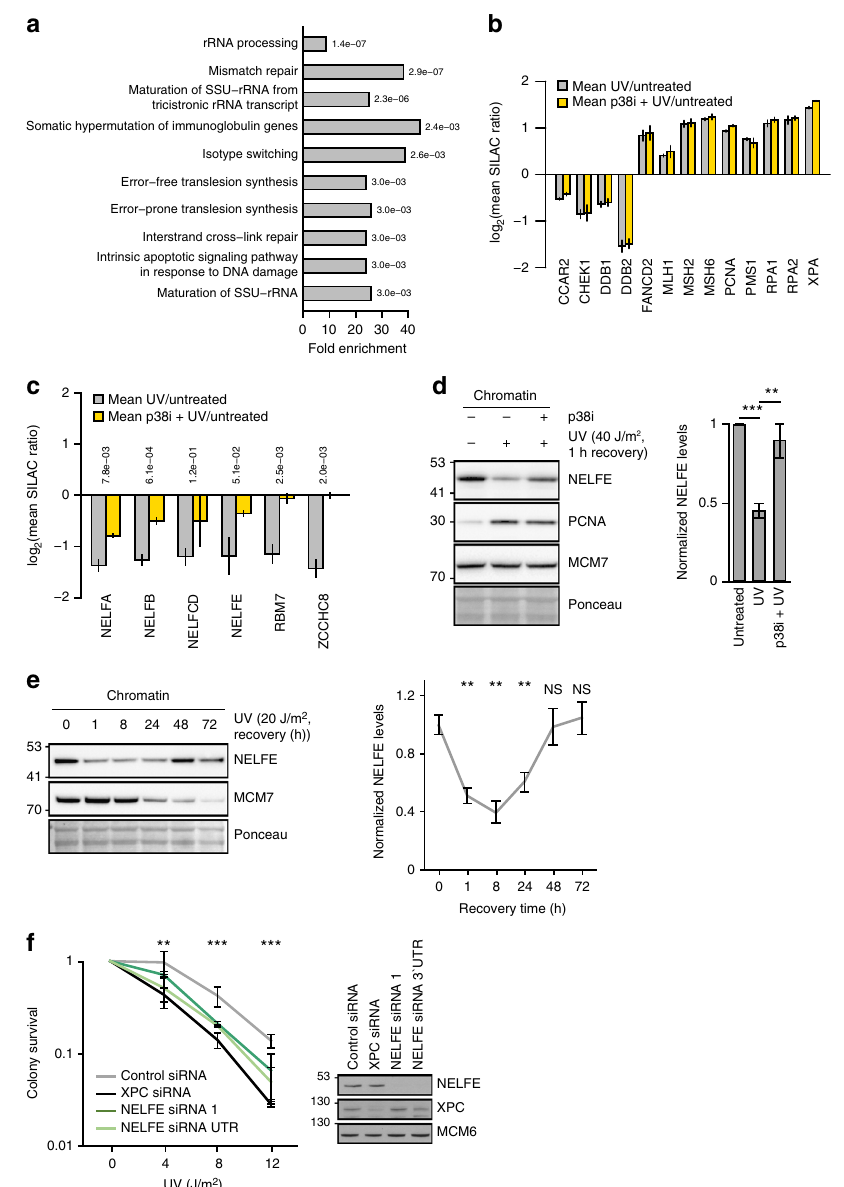
Fig. 6 p38-dependent phosphorylation of NELFE promotes its dissociation from chromatin. a Chromatin-associated proteins were extracted from untreated, UV-light-treated, and p38i, UV-light-treated U2OS cells, and analyzed by SILAC-based quantitative mass spectrometry. The bar plot shows the GO-BP (biological process) terms associated with proteins speci fi cally enriched on or removed from chromatin after UV light (40 J/m 2 , 1 h recovery). The signi fi cance of the enrichment of a speci fi c term was determined using Fisher ’ s exact test. P -values were corrected for multiple hypotheses testing using the Benjamini and Hochberg FDR. b The bar plot shows selected proteins associated with DNA repair and cell cycle that are signi fi cantly recruited or removed from chromatin after UV light. The error bars show the mean and SD of SILAC ratios quanti fi ed from three replicate experiments. Two-sided Student ’ s t -test was used to assess the signi fi cance. c The NELF complex subunits are removed from chromatin in a UV light and p38-dependent manner. The bar plot shows selected proteins whose removal from chromatin after UV light is dependent on p38. The error bars show the mean and SD of SILAC ratios quanti fi ed from three replicate experiments. Two-sided Student ’ s t -test was used to assess the signi fi cance. d NELFE dissociates from chromatin after UV light. Chromatin protein fractions from differentially treated U2OS cells were resolved by SDS-PAGE and subjected to western blotting with the indicated antibodies (left). The levels of NELFE on chromatin were quanti fi ed from three replicate experiments and normalized to MCM7 levels (right). The error bars show the mean and SD of SILAC ratios quanti fi ed from three replicate experiments. Two-sided Student ’ s t -test was used to assess the signi fi cance (*** p -value < 0.001, ** p -value < 0.01). e Dynamics of NELFE removal from chromatin. Chromatin protein fractions from differentially treated U2OS cells were resolved by SDS-PAGE and subjected to western blotting with the indicated antibodies. The error bars show the mean and SD of SILAC ratios quanti fi ed from three replicate experiments. Two-sided Student ’ s t -test was used to assess the signi fi cance (** p -value < 0.01). f Knockdown of NELFE reduced the ability of U2OS cells to form colonies after UV light. The error bars show the mean and SD of results obtained in three replicate experiments performed in three technical replicates. Two-sided Student ’ s t -test was used to assess the signi fi cance (*** p -value < 0.001, ** p -value <